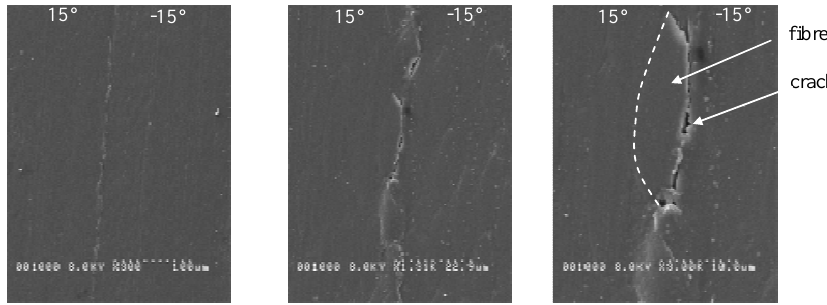
Fig. 8. SEM observations of damage at interlaminar interface in [(15/-15) 2 ] s pure-UD-HS